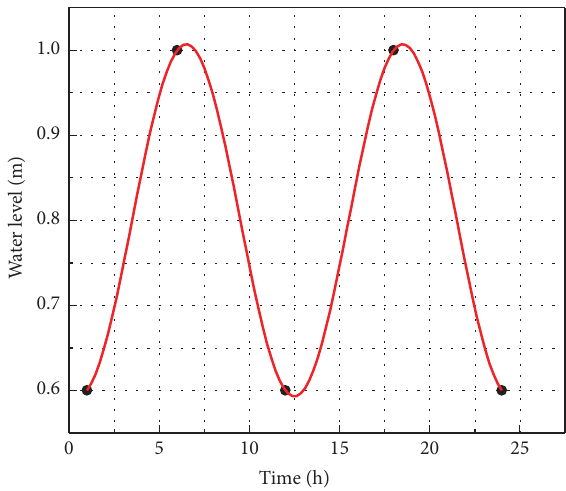
Figure 4: Tidal cycle of marine environment.